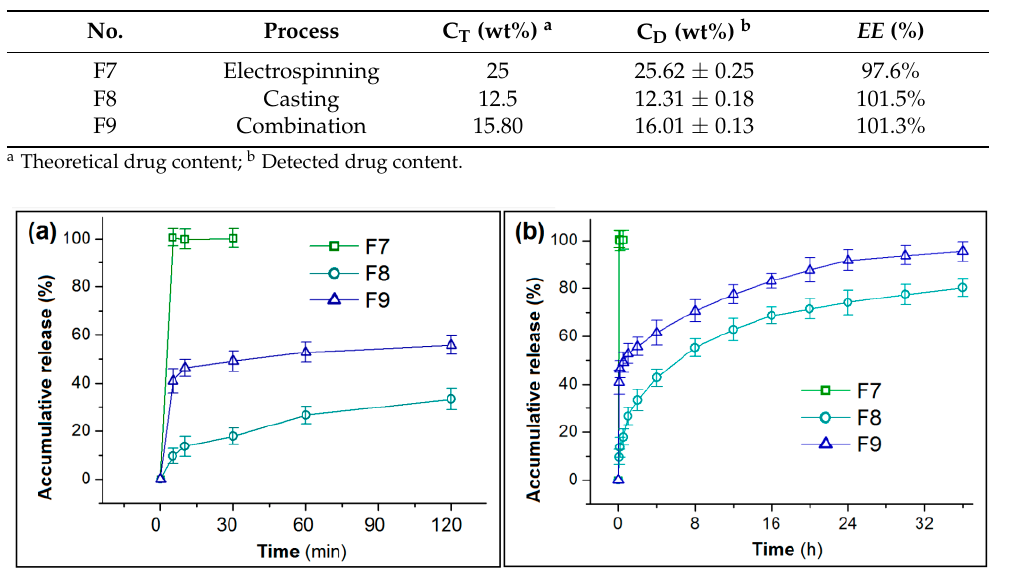
Table 2. Drug content in different prepared nanofibers ( n = 3).